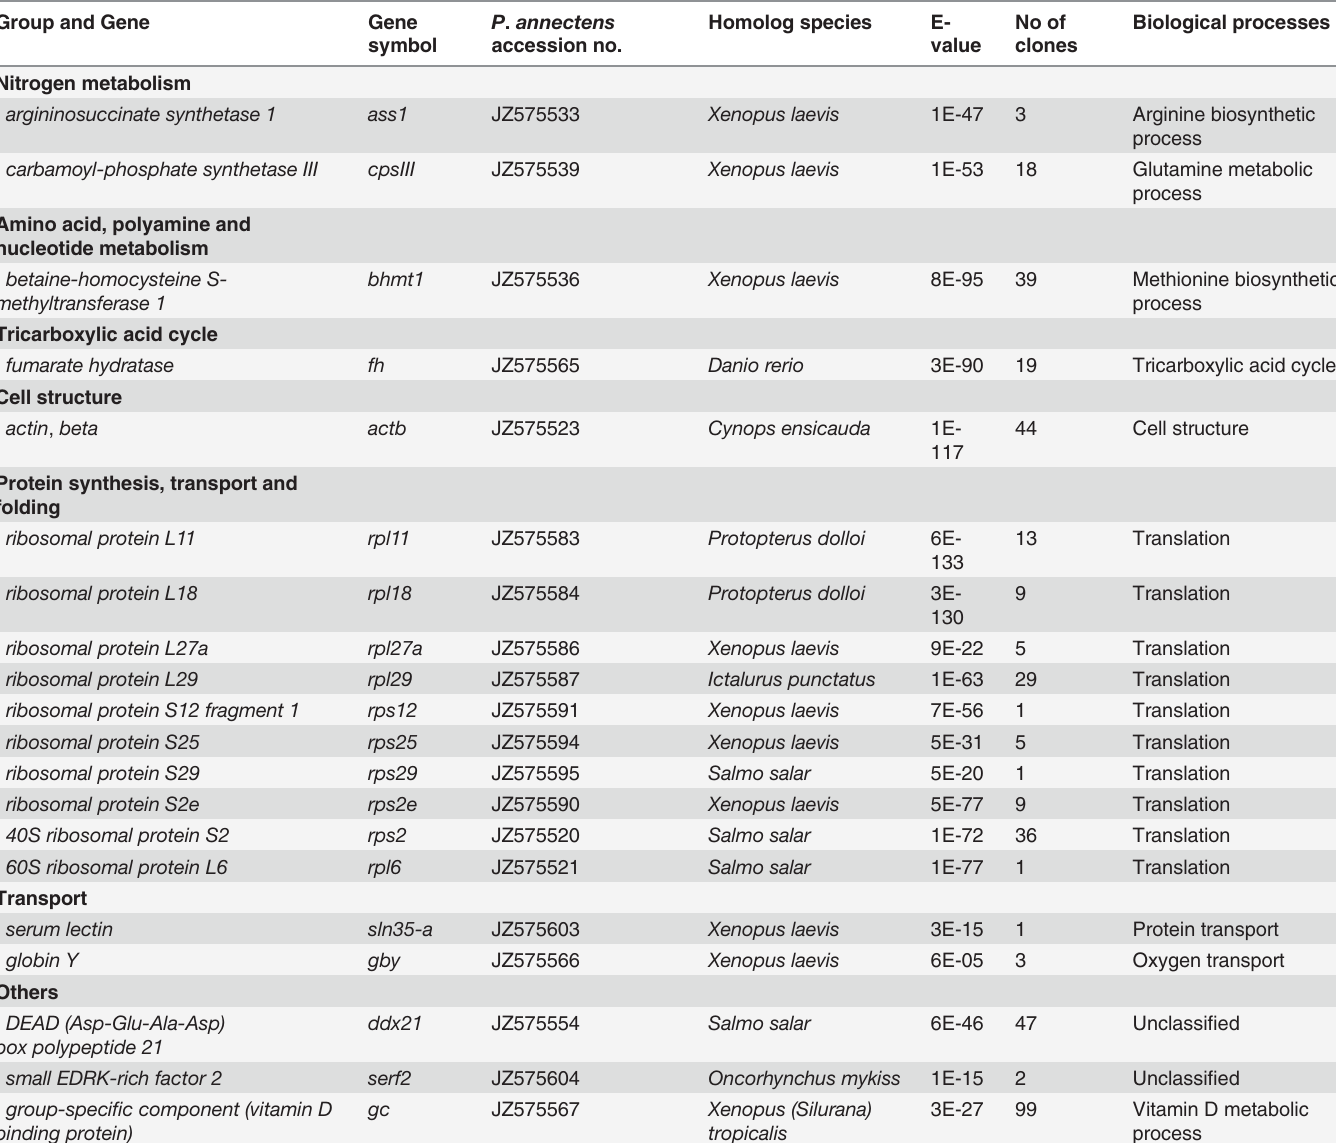
Table 2. Known transcripts found in the forward library (up-regulation) obtained by suppression subtractive hybridization PCR from the liver of Protopterus annectens aestivated for 6 months in air with fi sh kept in fresh water as the reference for comparison. Group and Gene Gene